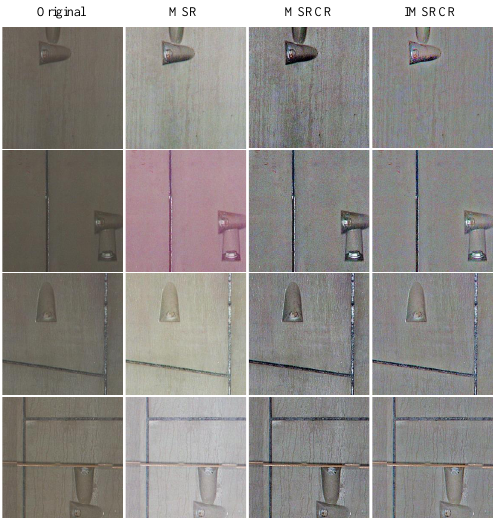
Figure 8. Examples of results from different color enhancement algorithm.